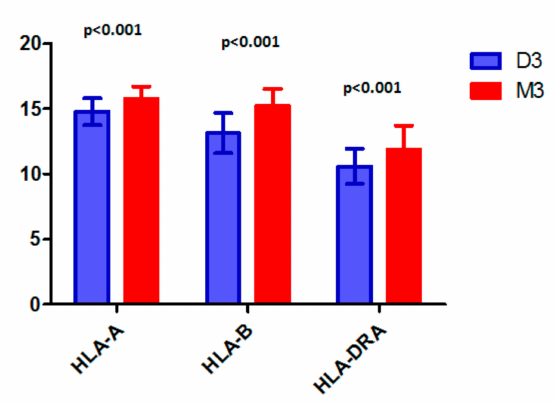
Figure 3. Comparison between HLA-A, HLA-B and HLA-DR expression in disomy 3 (D3) vs monosomy 3 (M3) tumors of The Cancer Genome Atlas (TCGA)